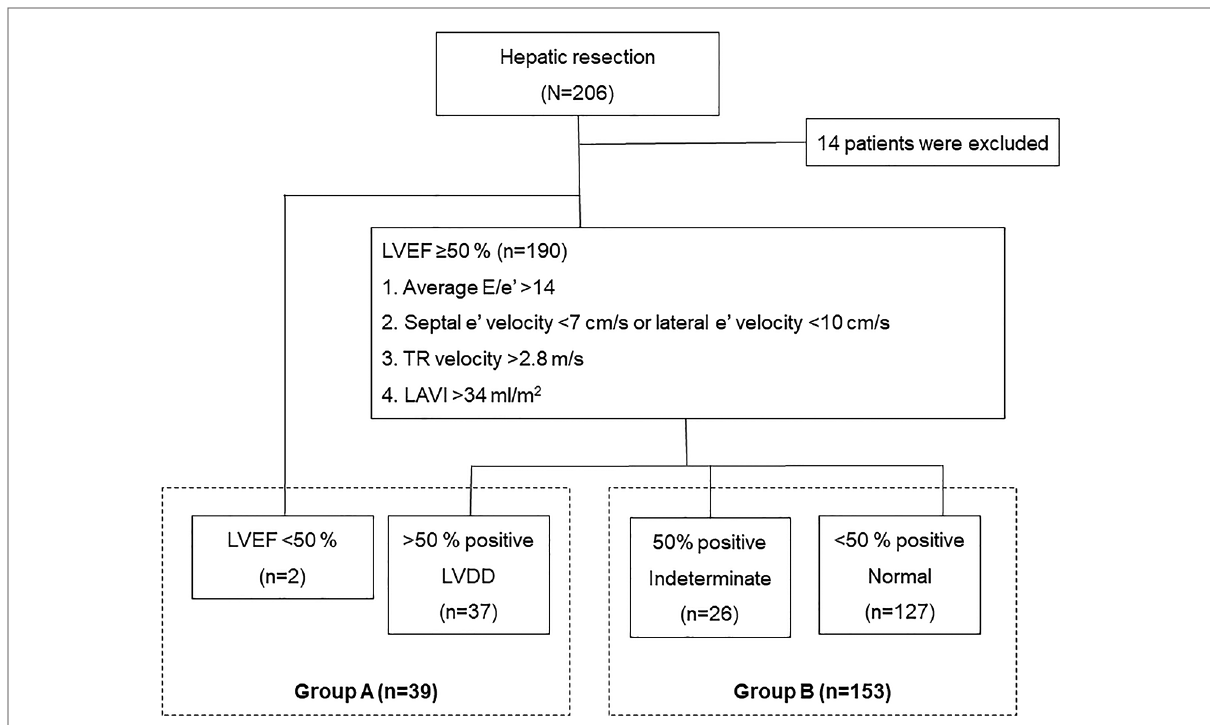
FIGURE 1 Patient inclusion fl owchart. The patients are classi fi ed according to their LV diastolic function assessed based on echocardiographic assessment using the ASE and the EACVI 2016 recommendations. LV, left ventricular; ASE, American Society of Echocardiography; EACVI, European Association of Cardiovascular